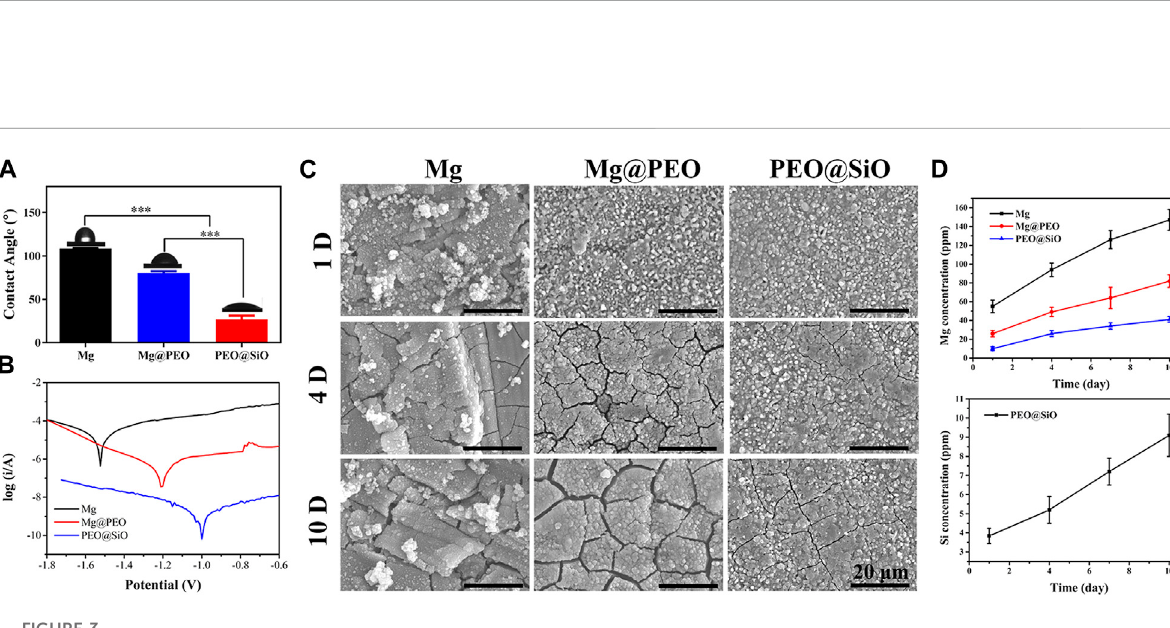
FIGURE 3 (A) Water contact angle, (B) potentiodynamic polarization curves, and (C) corrosion morphology of the Mg, Mg@PEO, and PEO@SiO samples. (D) Mg and Si ions released from various